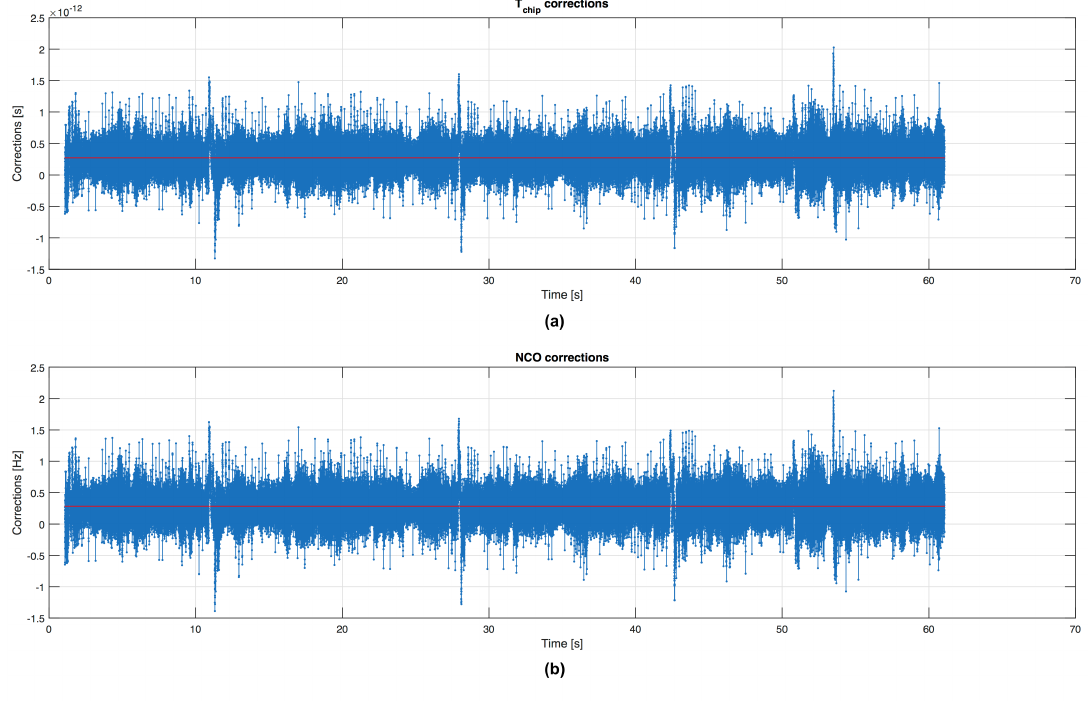
Figure 1. ∆ T chip [ n ] in time ( a ) and corrections of code frequency ∆ f c [ n ] for PRN 31 ( b ).